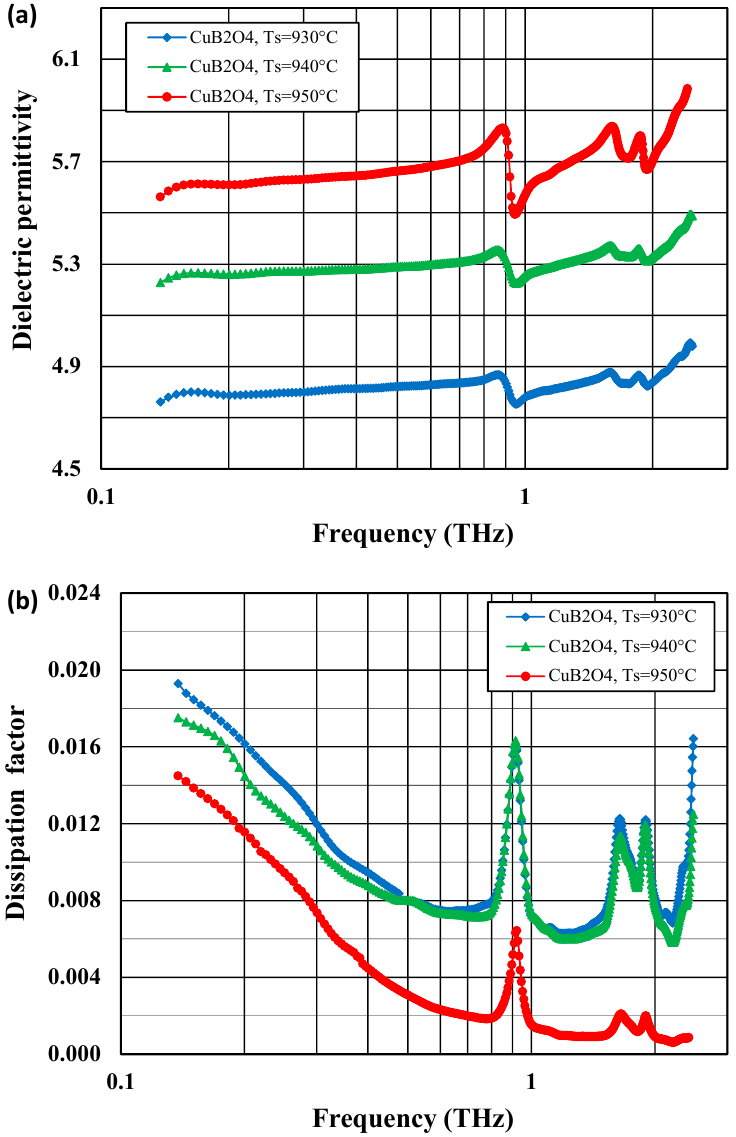
Figure 5. Comparison of dielectric permittivity ( a ) and dissipation factor ( b ) versus frequency in the range 0.12–2.5 THz for CuB 2 O 4 ceramics sintered at 930, 940, and 950 °C. The dissipation factors are relatively low (0.004–0.01) in the 0.14–0.7 THz range, with a flat minimum at 0.4–0.6 THz. A few peaks on the dissipation factor versus frequency